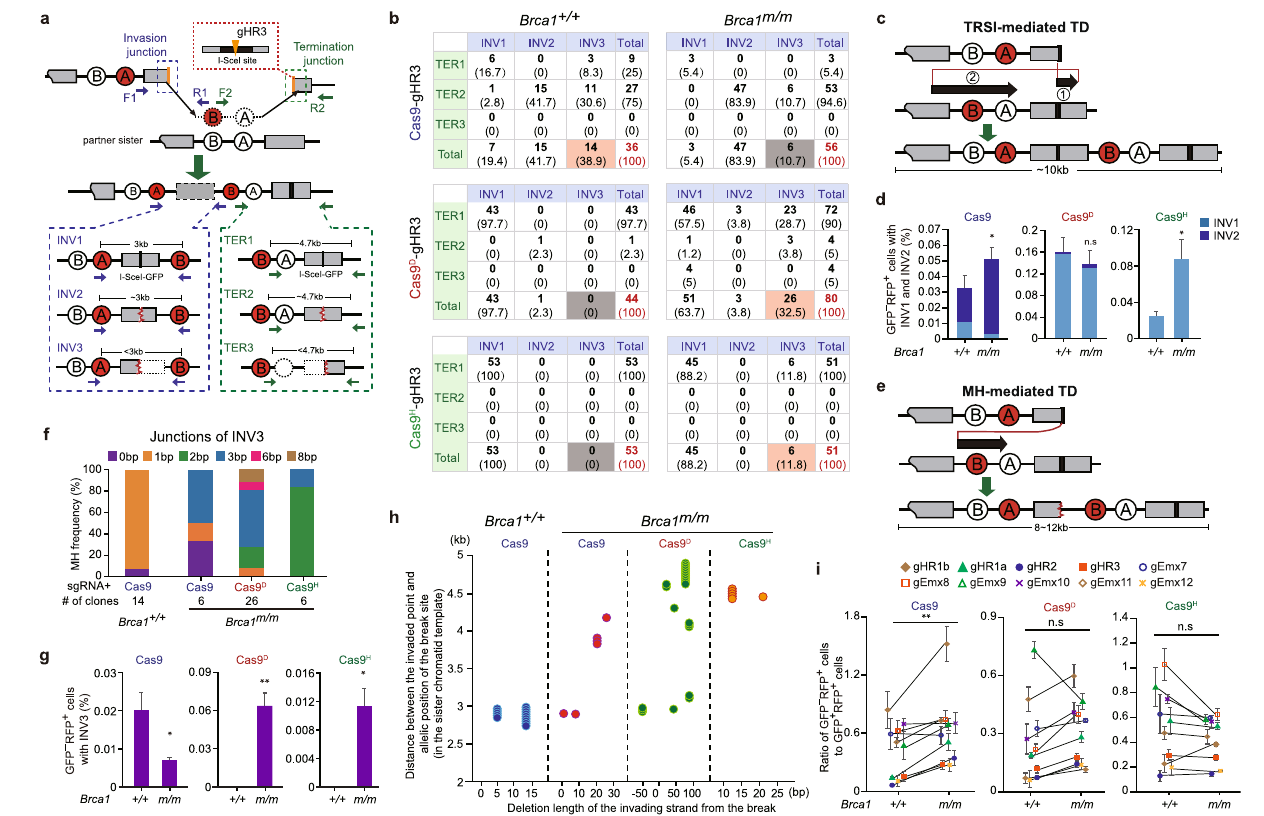
Fig. 6 | Nick-induced TDs suppressed by BRCA1 are mediated either by two- round strand invasion or by MH. a Structural classi fi cation of TD products induced by Cas9-gHR3 and nCas9-gHR3. After induction of a two-ended or one- endedDSBbyCas9-gHR3andnCas9-gHR3,resultsinTDs(i.e.,GFP − RFP + cells),three types of invasion junctions, i.e., INV1, INV2 and INV3 (blue dotted frame), can be determinedandclassi fi edbyPCRwithprimersF1andR1asindicatedbybluearrows and three types of termination junctions, i.e., TER1, TER2 and TER3 (green dotted frame),withprimersF2andR2asindicatedbygreenarrows.Thestraightblackline and curve red lines within I-Sce-GFP indicate an intact and mutated I-SceI site, respectively. The dotted square and circle in INV3 and TER3 denote deletion. b Number (in bold) of Cas9- or nCas9-induced TDevents with each combined type of invasion and termination junctions in Brca1 +/+ and Brca1 m/m cells. The portion of each combined type in GFP − RFP + cells analyzed is shown in parenthesis. c TRSI- mediated TD model. The fi rst homologous strand invasion into allelic I-Sce-GFP restores the I-SceI site and the second homologous strand invasion into TrGFP allows TD of the RFP exon B and A cassette. d Frequency of Cas9- and nCas9- induced TRSI-mediated TDs in Brca1 +/+ and Brca1 m/m cells. TRSI-mediated TDs are characterizedbyGFP − RFP + cellswithINV1orINV2.Thefrequencyiscalculatedasthe